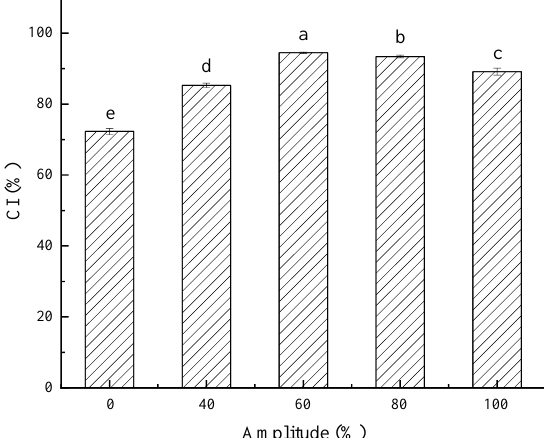
Figure 1. CI (%) after different ultrasonic-amplitude processing. Lowercase letters indicate a statis- tically significant difference within the group ( p ≤ 0.05) . Error bars represent standard deviation (n = 3).